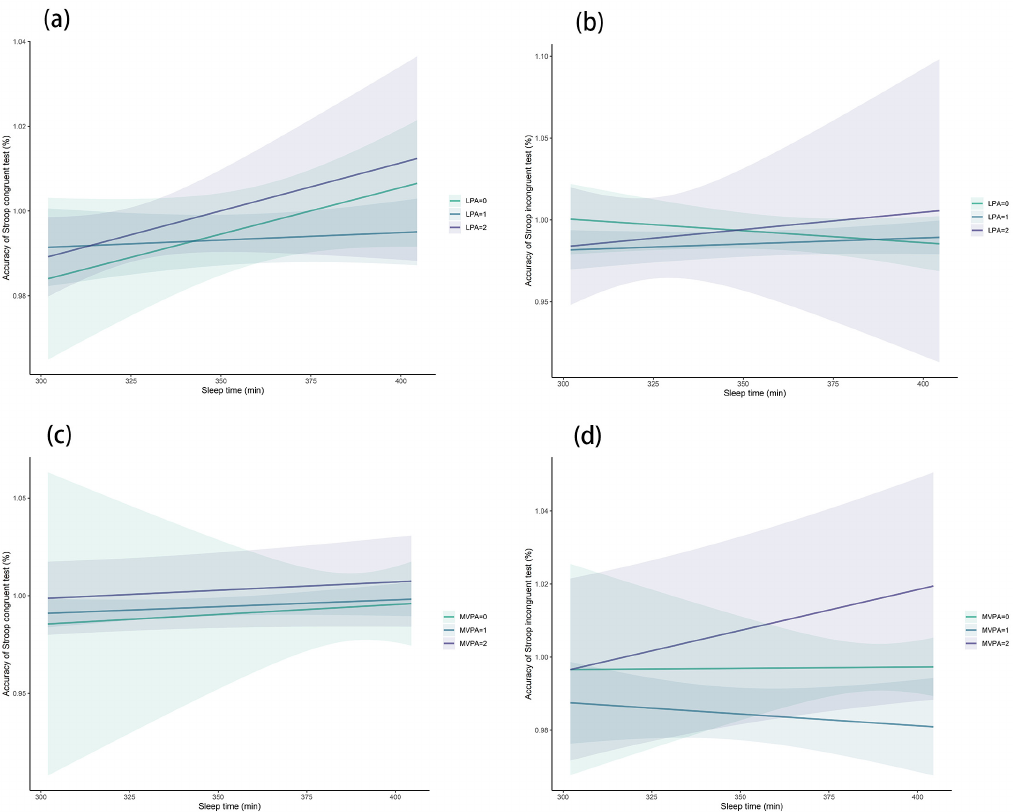
Figure 2. Association between sleep time and congruent ( a ) and incongruent ( b ) Stroop accuracy under different levels of light physical activity; association between sleep time and congruent ( c ) and incongruent ( d ) Stroop accuracy under different levels of moderate-to-vigorous physical activity.